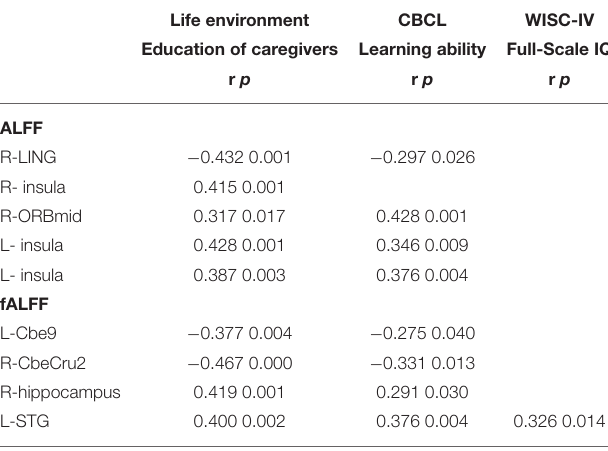
TABLE 5 | Association between values of ALFF and fALFF and living environment and behavioral and cognitive assessment.